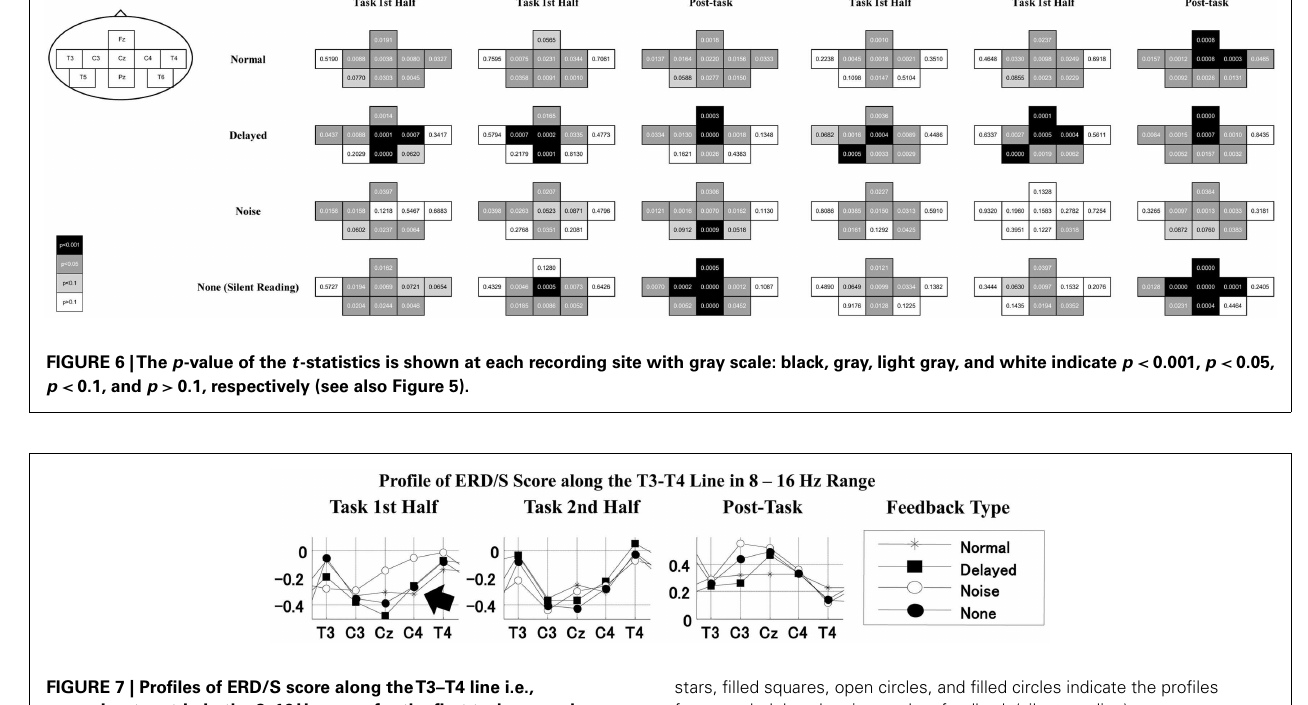
stars, filled squares, open circles, and filled circles indicate the profiles for normal, delayed, noise, and no feedback (silent reading),